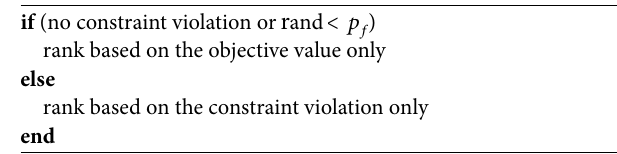
Table 1: Stochastic ranking. r and ) < 𝑝 𝑓